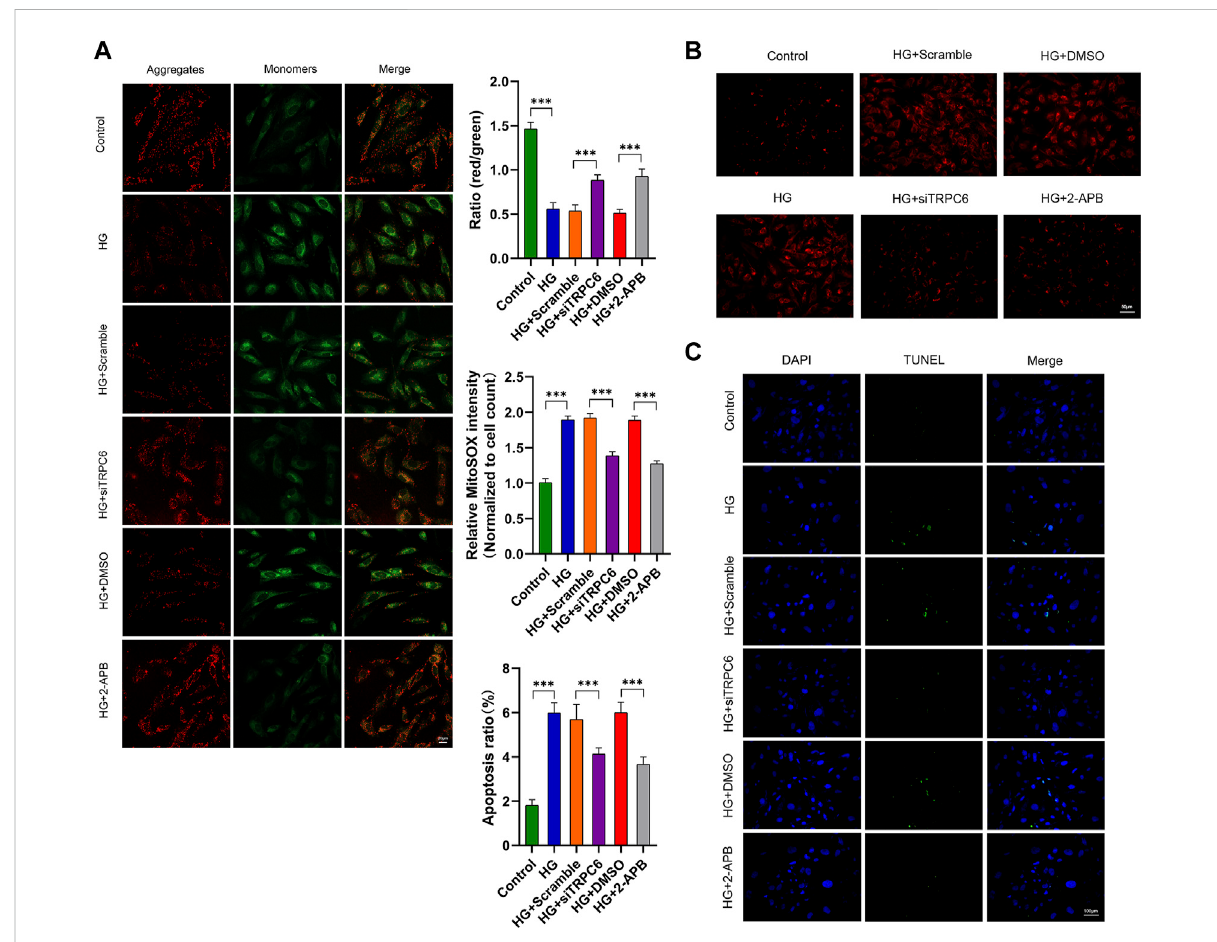
FIGURE 3 Effects of TRPC6 inhibition on mitochondrial functions in podocytes under HG conditions. (A) JC-1 staining and fl uorescence analysis in the control, HG, HG + scramble, HG + siTRPC6, HG + DMSO, and HG + 2-APB groups. Scale bars, 20 μ m ( n = 3 independentexperiments). (B) MitoSOX Red staining and fl uorescence analysis in the six groups. Scale bars, 50 μ m ( n = 3 independent experiments). (C) TUNEL staining and quantitation analysis of apoptotic cell number (%) in the six groups. Scale bars, 100 μ m ( n = 3 independent experiments). *** p <